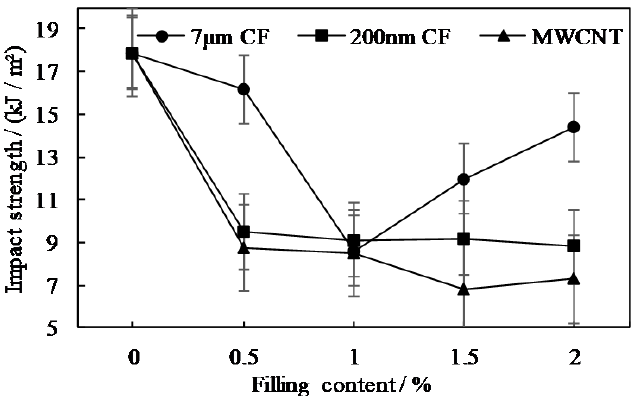
Figure 7. Impact properties of micro/nano CF and MWCNT modified PTFE.